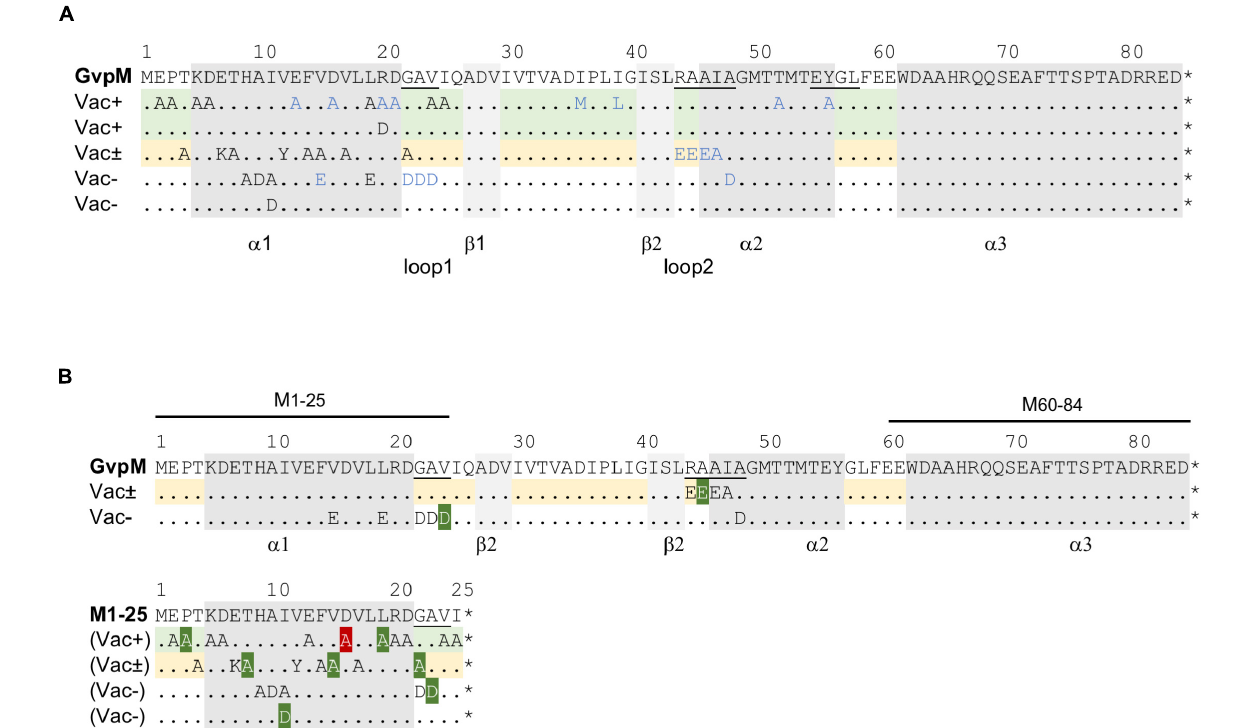
FIGURE 5 | Mutations in GvpM and in fragment M1–25. (A) Amino acid sequence of GvpM with the α -helices (gray) and β -sheets (light gray). Dots indicate aa identical to GvpM. The GAV, RAAIA, and EYGL motifs are underlined. (A) Summary of the single aa substitutions leading to a Vac + , Vac ± or Vac − phenotype. Each letter represents a single aa substitution. The blue letters are substitutions investigated by Tavlaridou et al. (2014). The lines indicating substitutions in GvpM yielding Vac + (cid:49) M + M mut transformants are shaded in green, and the lines with substitutions yielding a Vac ± phenotype are in yellow. (B) Summary of the fluorescence of L/M mut or L/M1–25 mut transformants in relation to the Vac phenotype of the respective (cid:49) M + M mut transformants. The lines on top of GvpM indicate the aa present in fragments M1–25 and M60–64. The aa substitutions yielding a higher fluorescence are shaded in dark green, whereas the D16A substitution yielding a significantly lower fluorescence of the respective L/M1–25 D16A transformant is shaded in red. ∗ marks the end of the respective